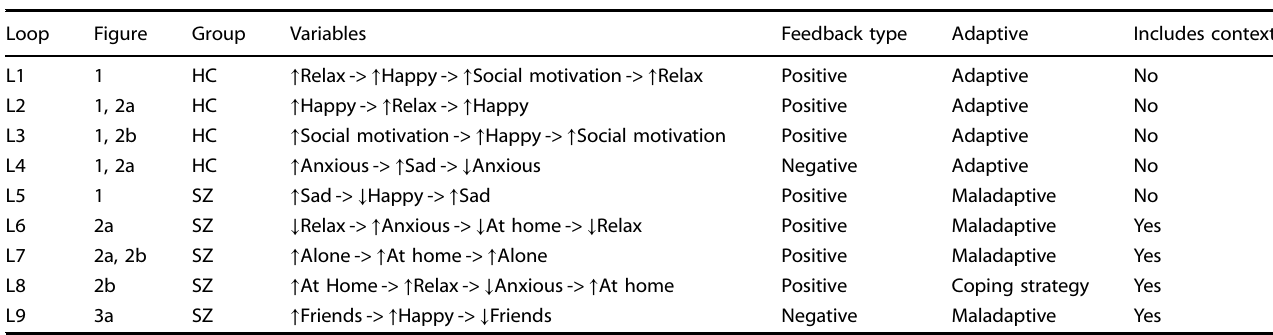
Table 2. Summary of feedback loops in network models. Loop Figure Group